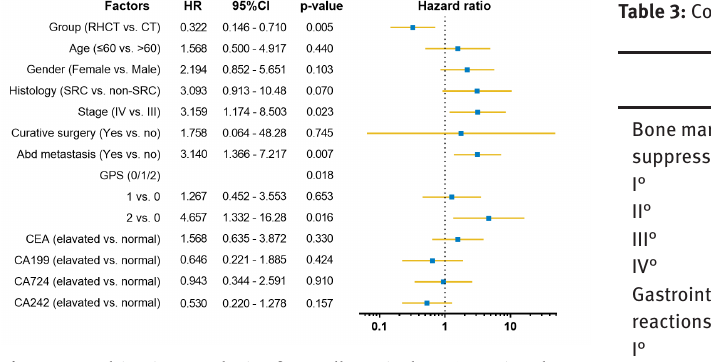
Figure 3: Multivariate analysis of overall survival. RHCT regional hyperthermia with chemotherapy; CT chemotherapy; SRC signet- ring cell carcinoma; GPS Glasgow Prognostic Score